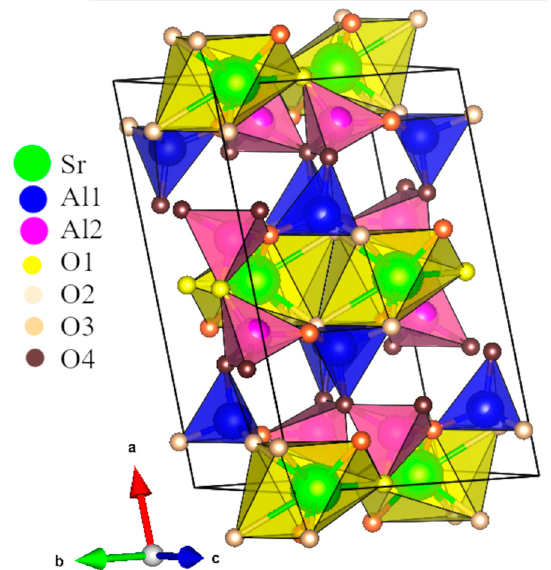
Figure 8. Polyhedral representation of SrAl 4 O 7 structure. Two types of AlO 4 tetrahedra (blue Al1O 4 and pink Al2O 4 ones) and SrO 7 polyhedra (yellow) are shown. The a , b , and c indicate corresponding crystallographic axes.